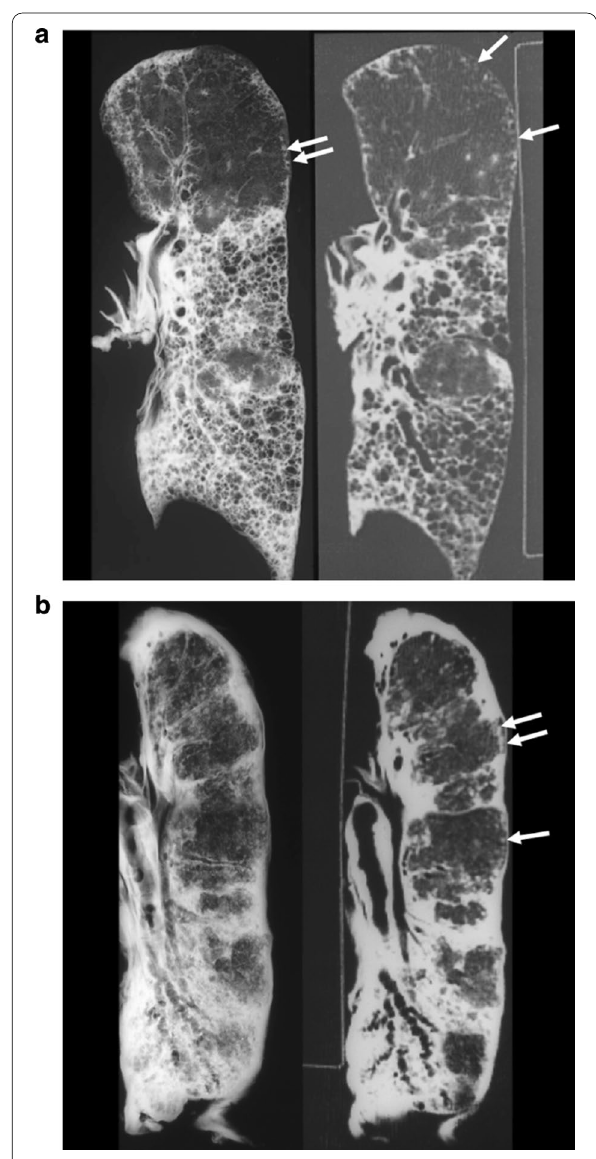
Fig. 2 Two types of advanced asbestosis. a A honeycomb type of asbestosis. Postmortem low-kilovoltage radiograph and HRCT scan of the inflated and fixed left lung shows honeycombing in the lower two-thirds of the lung. In the subpleural zones of upper lung, dot-like lesions are seen (arrows). b An atelectatic fibrosis type of asbestosis. Postmortem low-kilovoltage radiograph and HRCT scan of the inflated and fixed left lung shows diffuse pleural thickening and consolidated area extending along the bronchovascular sheath. Traction bronchiectasis is seen in the consolidated area. Honeycombing is not seen radiologically. In the subpleural zones of upper lung, subpleural dots and subpleural lines are also seen